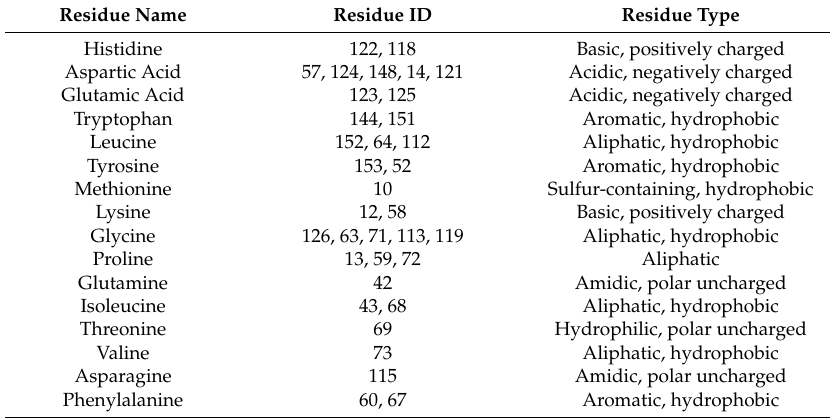
Table 1. Residues within 5 Angstrom of Graphene Oxide Surface.